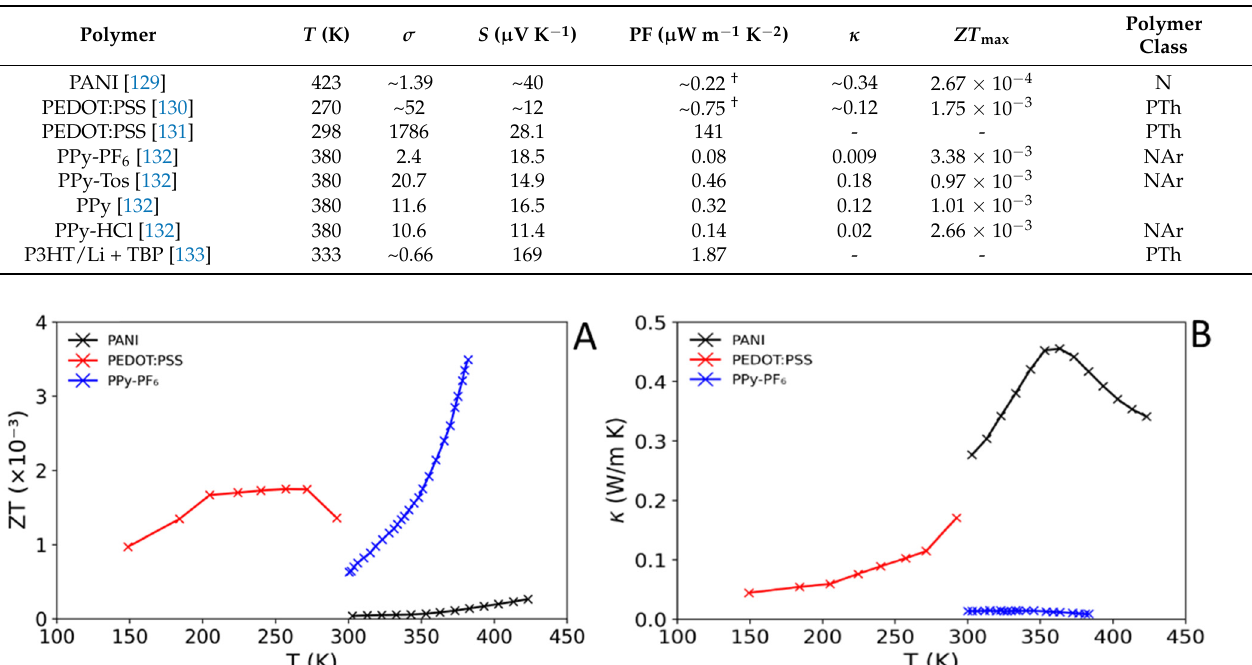
Figure 4. Comparison of ZT ( A ), and 𝜅 ( B ) for typical polymer TE materials used within inor- ganic/polymer composites as a function of temperature (K). PANl [129], PEDOT:PSS [130], and PPy-PF 6 [132].